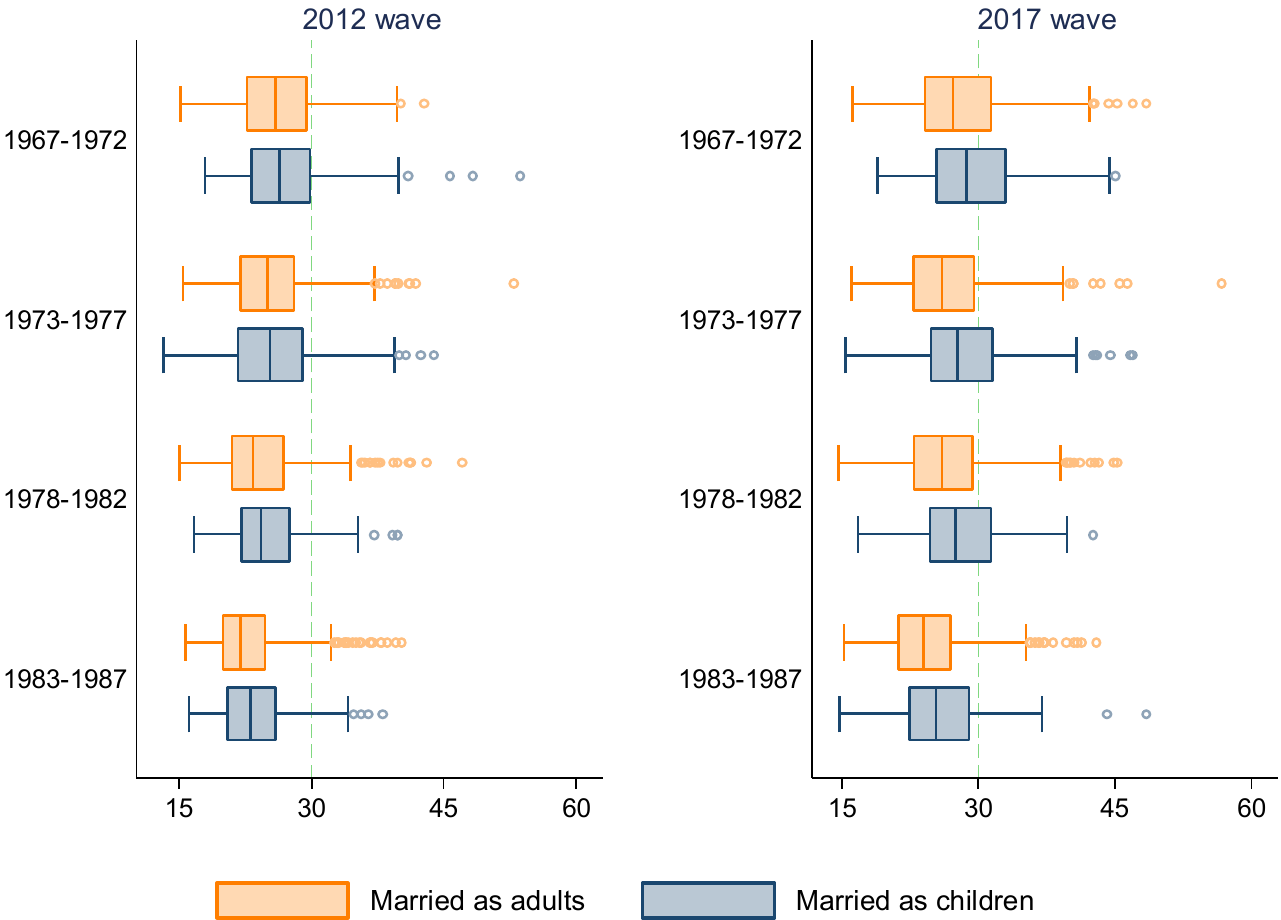
Figure 4. Box plot of BMI by child marriage across birth cohorts and survey waves. The box represents the 25th percentile, median, and 75th percentile values, from left to right. The bars on the left and right of the box represent lower and upper adjacent values, respectively. The circles represent outside values.